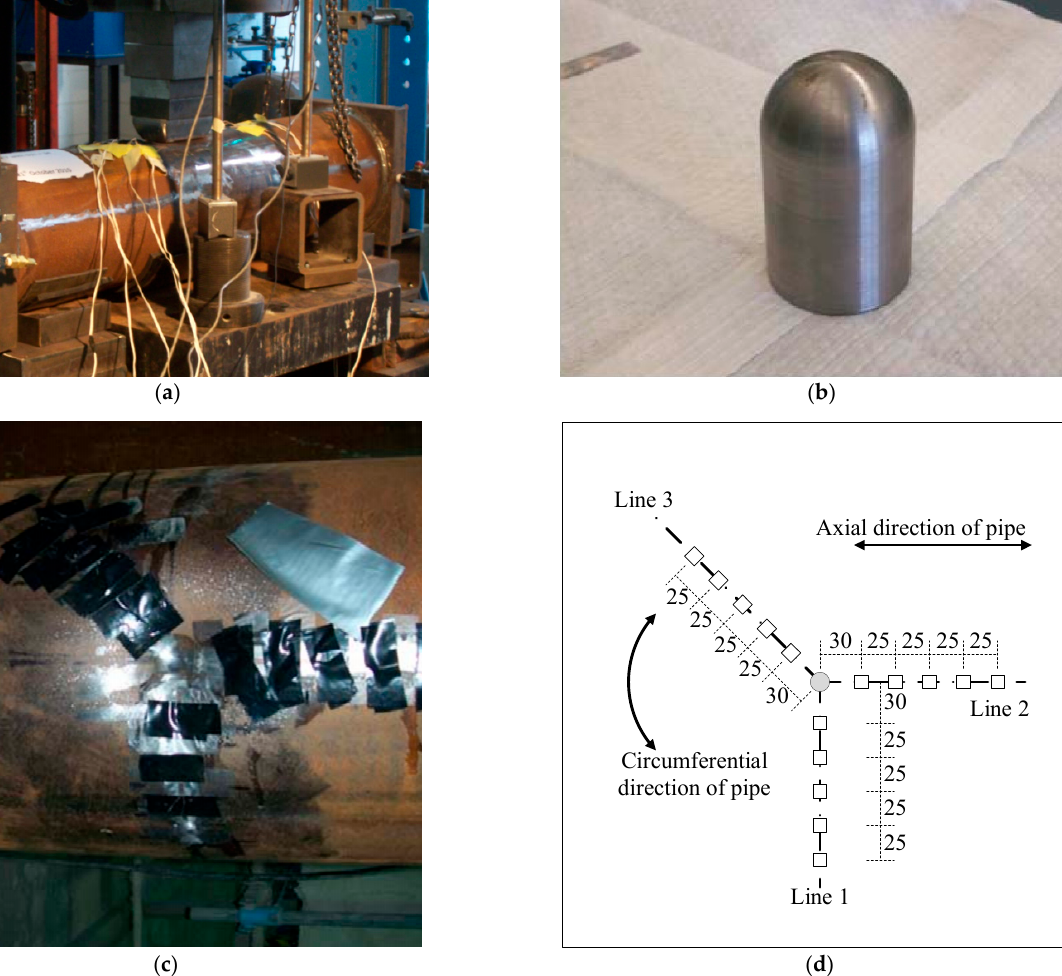
Figure 4. Mesh generation of the dented pipe model.